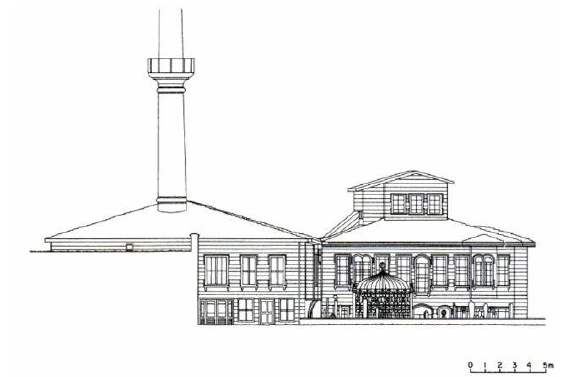
Figure 4. Front view of the mosque and cemetery (Teza and Pesci,